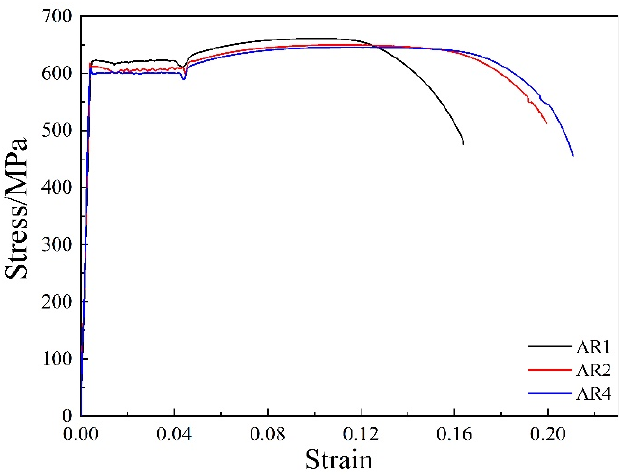
Figure 7. Stress–strain curve of samples annealed at 600 °C for different time.